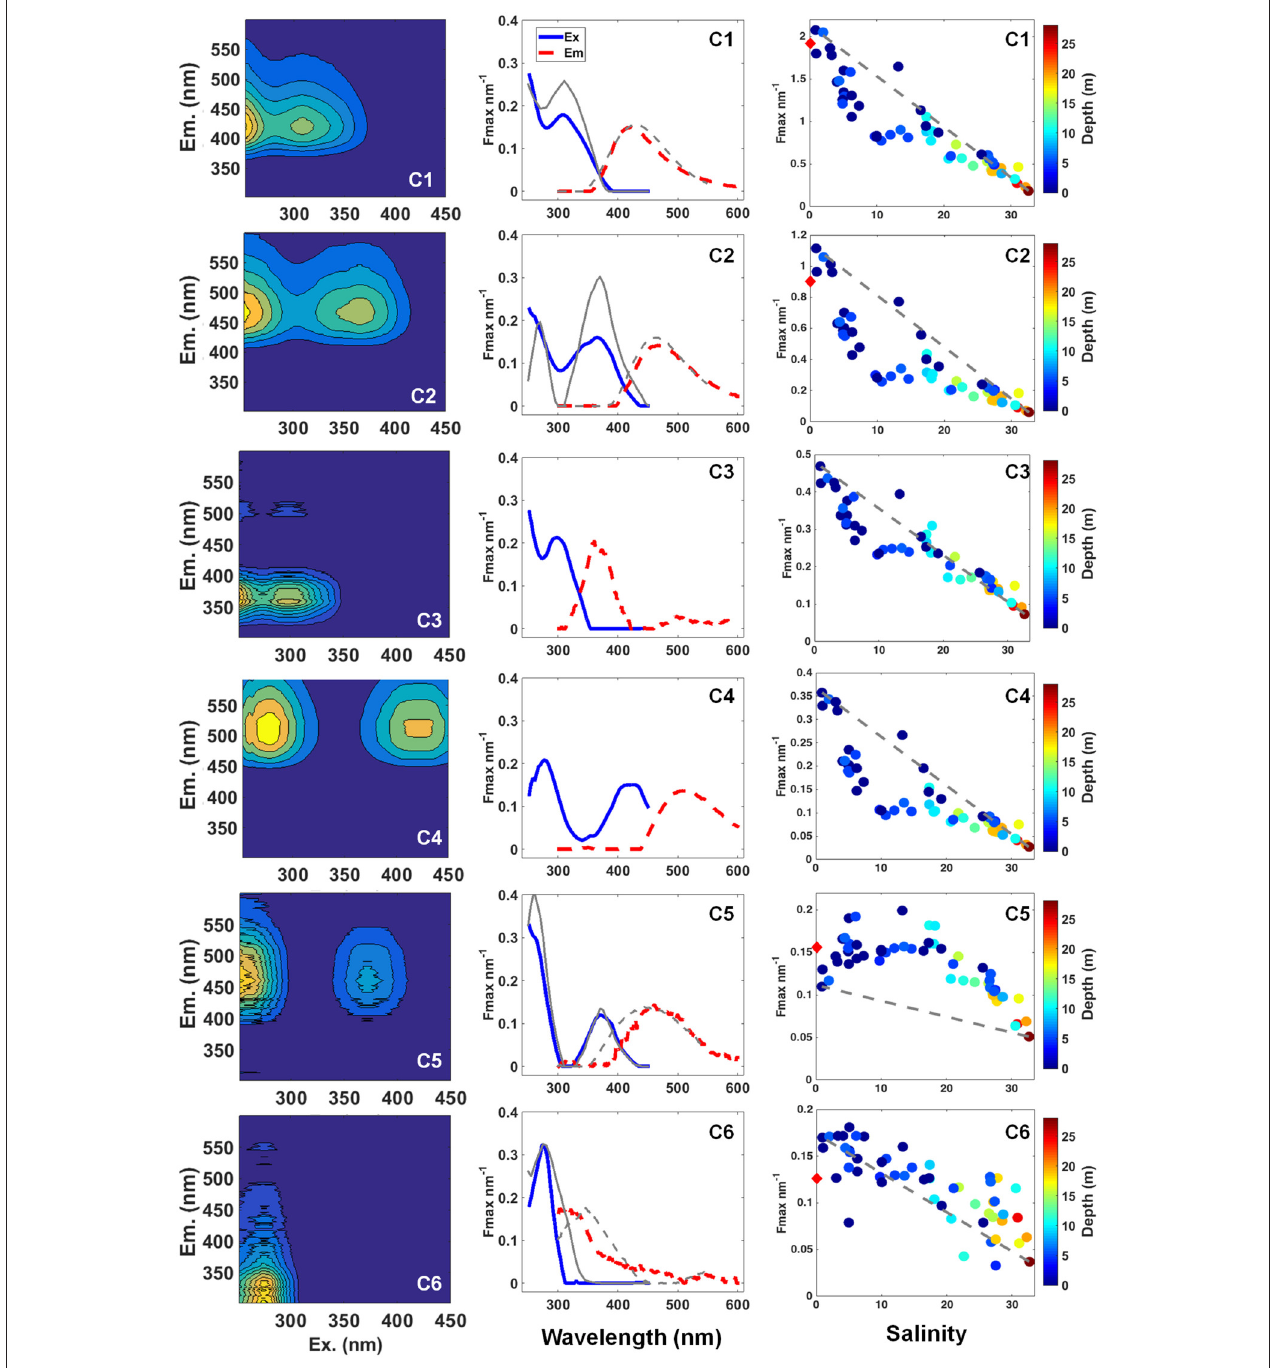
FIGURE 4 | Three-dimensional fluorescence landscapes (left), the excitation (solid line) and emission (dashed line) spectra (center), and F max (nm − 1 ) against salinity and depth (m; right) for each of the six fluorescent components identified by PARAFAC model for all the samples. Gray lines displayed in components spectra graphs (center) show the spectra for components previously found in the major Arctic Rivers (Walker et al., 2013). Gray dashed-lines in F max against salinity plots (right) indicate the hypothetical conservative mixing line between each of the components and salinity. Red diamonds in y-axis indicate averaged F max values for similar components found in the Lena River during periods of peak discharge (for C1 and C2) and mid flow (for C5 and C6; Walker et al., 2013).